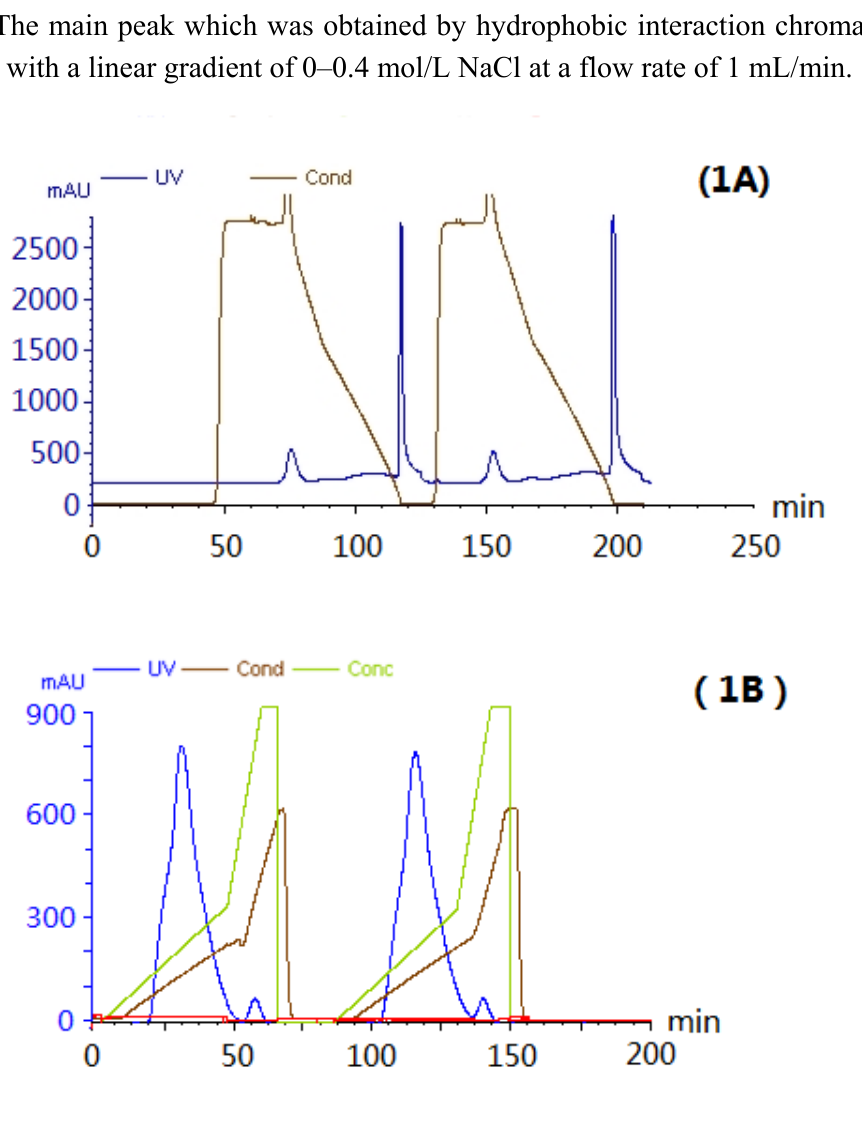
Figure 1. The purification of AEL by hydrophobic interaction chromatography and ion exchange chromatography. The elution profiles were monitored at 280 nm. ( A ) Hydrophobic interaction chromatography of protein on Hiprep TM Phenyl FF column (10 mL). The bound protein was eluted with a linear gradient of 0.6–0.3 mol/L (NH ) SO for 15 min, then with 4 2 4 0.3–0 mol/L (NH ) SO for 30 min, finally with H O at a flow rate of 1 mL/min; ( B ) Ion 4 2 4 2 exchange chromatography on HiTrap TM column pre-equilibrated with Tris-HCl buffer [pH 8.0]. The main peak which was obtained by hydrophobic interaction